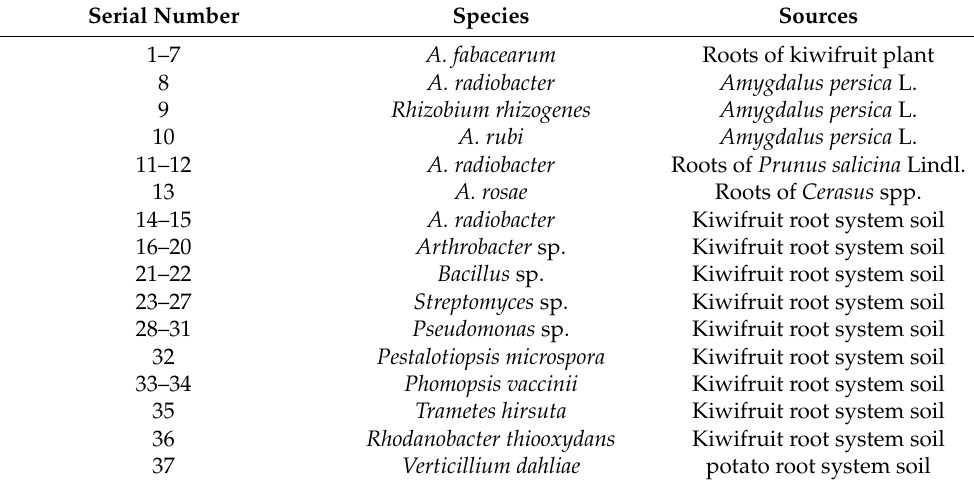
Table 2. The species used for the LAMP specificity test.